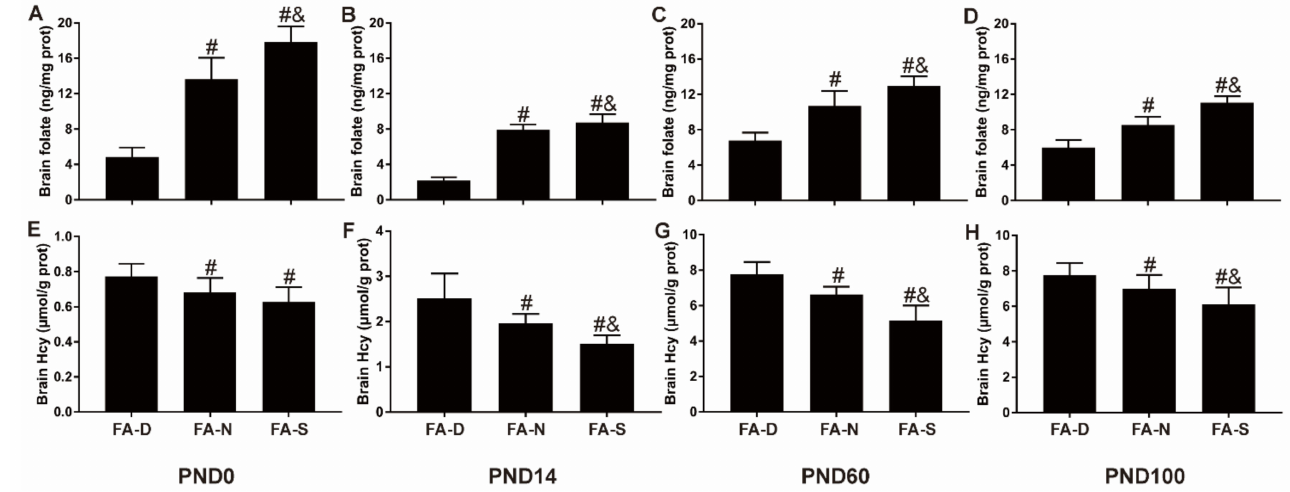
Figure 1. Folic acid supplementation increased the level of folate and decreased the level of Hcy in the brain tissue of offspring. Five-week-old female rats were randomly divided into three